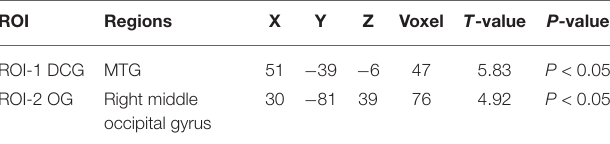
TABLE 3 | Compared with the control group, the FC values between the DCG and MTG. ROI Regions